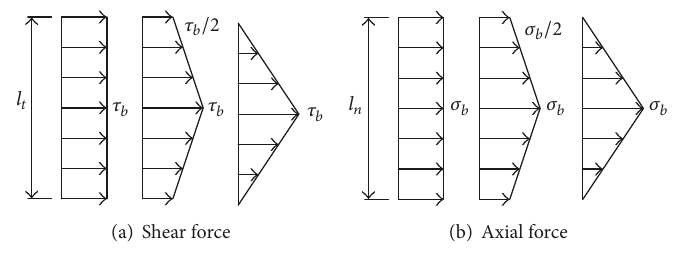
Figure 9: Axial and shearing forces on the